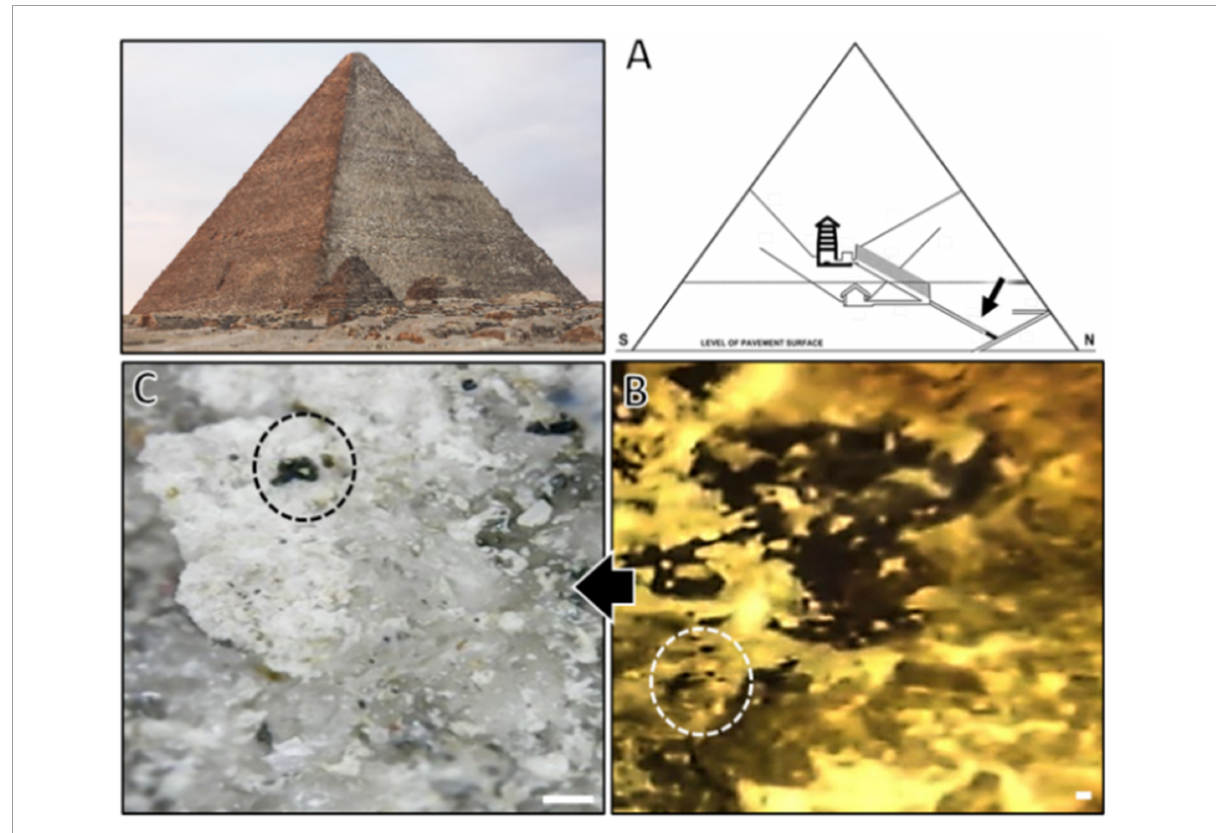
FIGURE1 (A) Schematic drawing of Khufu’s Great Pyramid showing the sampling site in the pyramid; (B) a zoomed micrograph of the spotted site; (C) stereomicroscopic micrograph showing black spots presumably composed of black fungi growth (circles) visible over the sampled crust surface (scale bar is 1